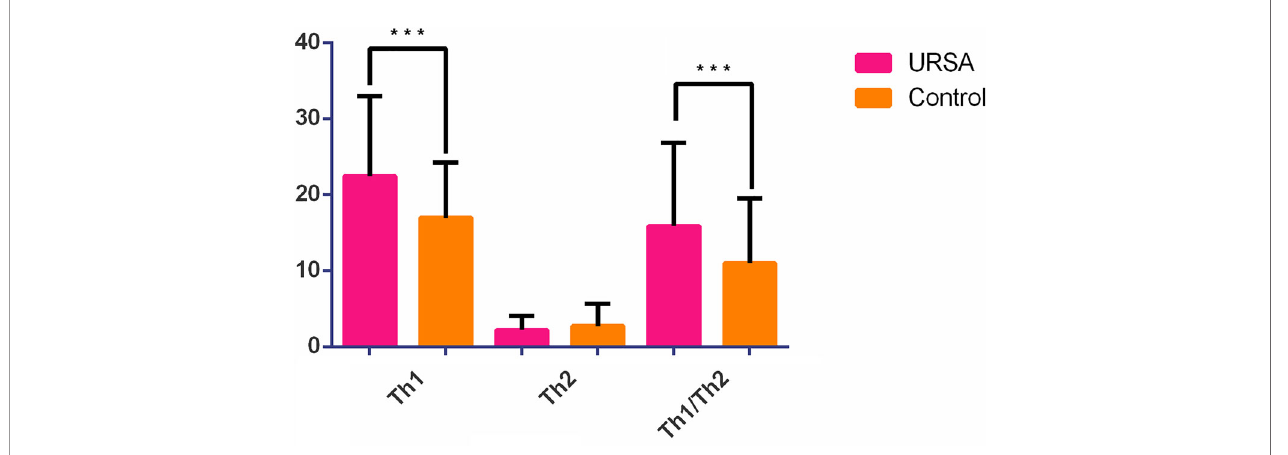
FIGURE 6 | Histogram of Th1 (IFN- g ), Th2 (IL-4), and Th1/Th2 ratio. *** p <